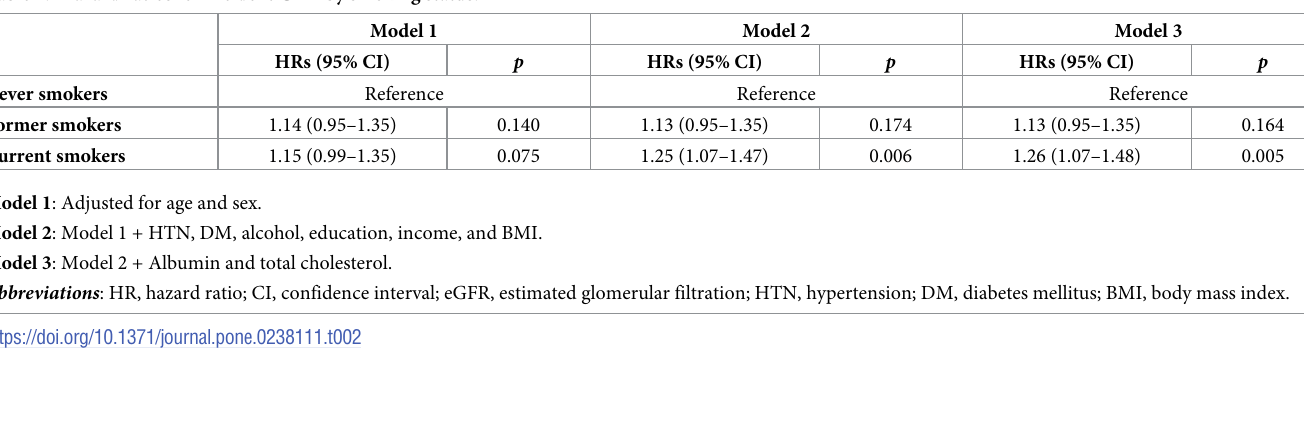
Table 2. Hazard ratios for incident CKD by smoking